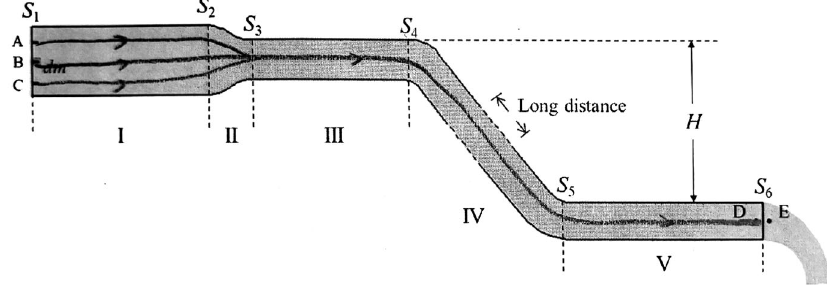
FIG. 3. A drawing of streamlines by a teacher participant